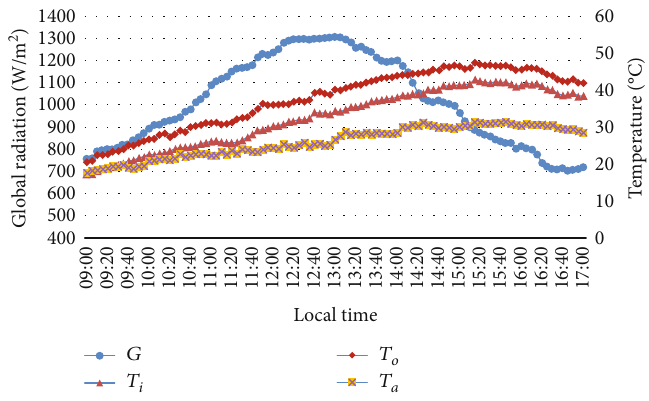
Figure 8: Solar radiation and temperature graphics for pure